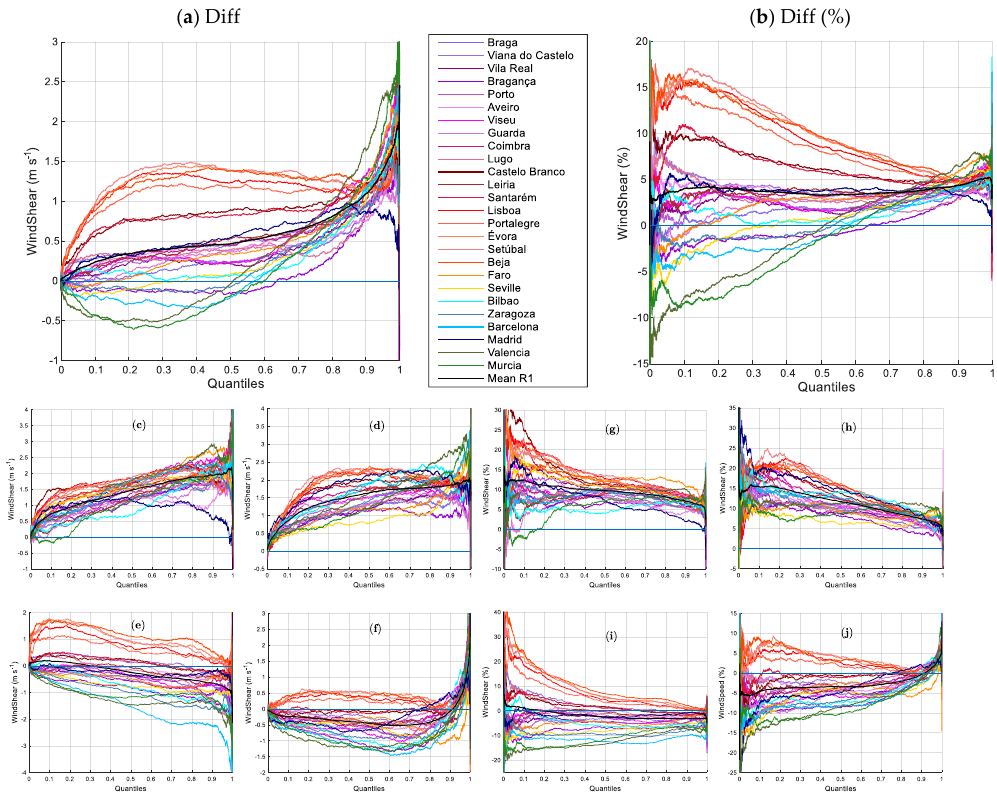
Figure 13. Differences (future-historic) for wind shear 0–6 km for annual and seasonal conditions, as a function of the quantiles of the corresponding empirical distributions. ( a ) Absolute differences (m s −1 ) and ( b ) relative percentual differences (%). Seasonal absolute differences are also represented for ( c ) winter, ( d ) spring, ( e ) summer and ( f ) autumn, and Seasonal percentual differences for ( g ) winter, ( h ) spring, ( i ) summer and ( j ) autumn.The black line (Mean R1) refers to the mean of region 1 (total area).